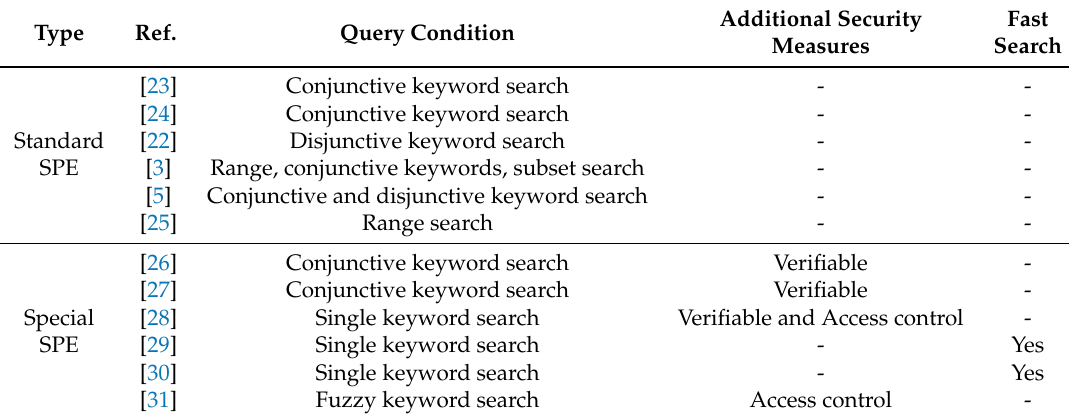
Table 1. Summary of previous searchable public key encryption